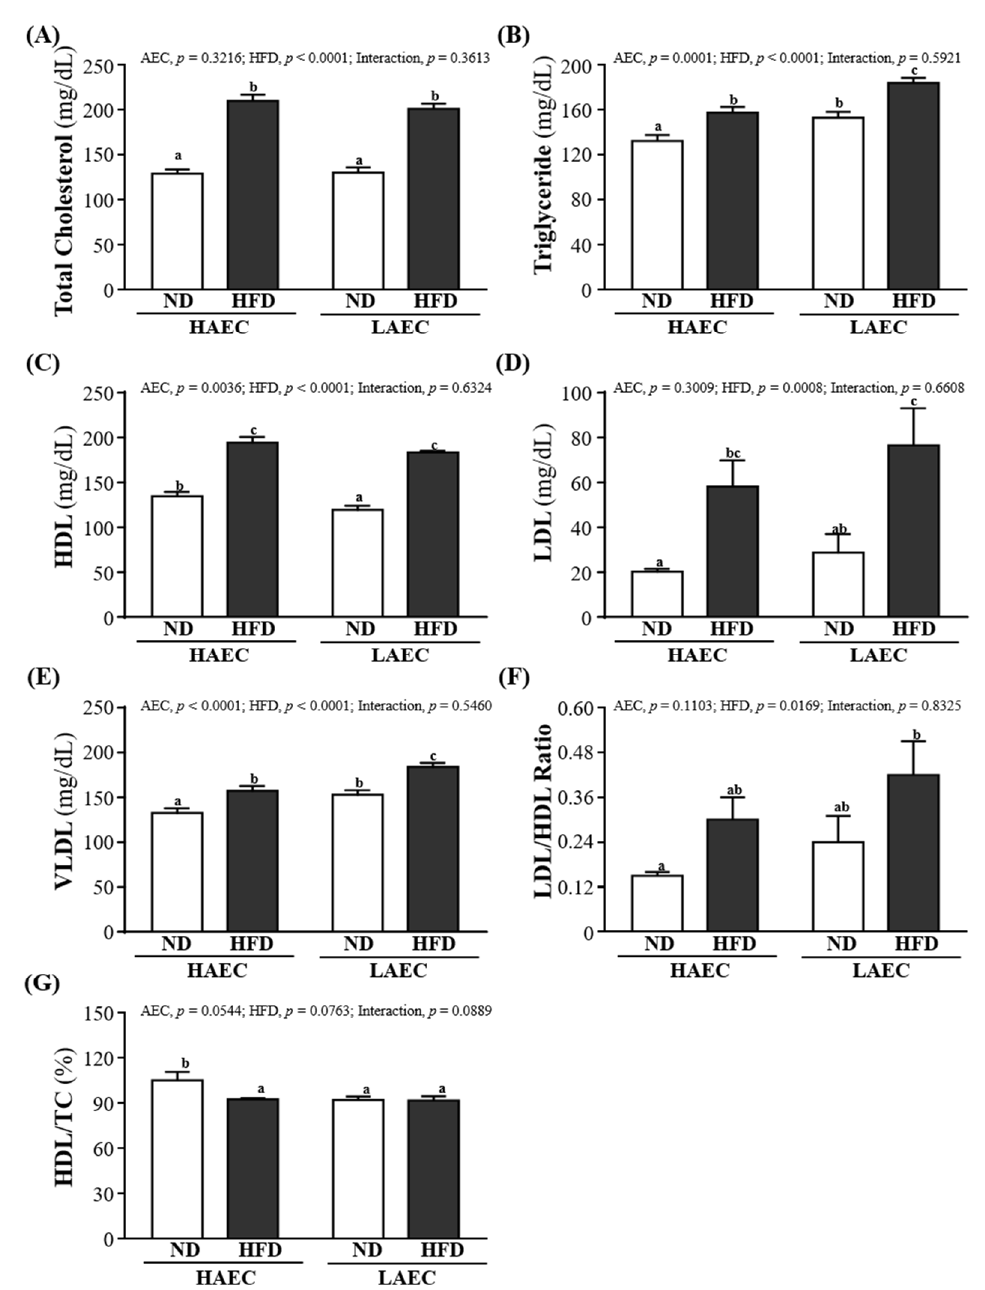
Figure 6. Effects of 12 weeks’ HFD feeding of HAEC or LAEC postpartum mice on blood lipid pa- rameters: ( A ) total cholesterol (TC); ( B ) triglyceride (TG); ( C ) high-density lipoprotein (HDL); ( D ) low-density lipoprotein (LDL); ( E ) very low-density lipoprotein; ( F ) LDL/HDL ratio; and ( G ) HDL/TC ratio. Data are mean ± SEM for n = 8 mice per group. Columns with different superscript letters (a, b, c) are significantly different between groups at p < 0.05.